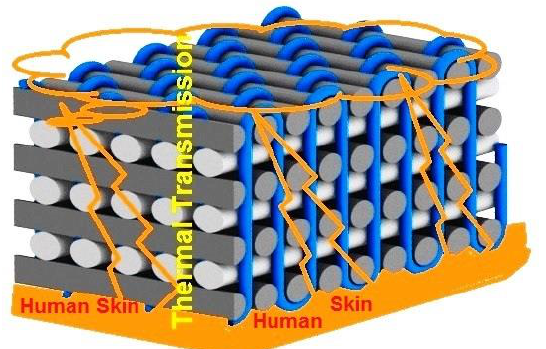
Fig. 1. Thermal conduction from human skin to